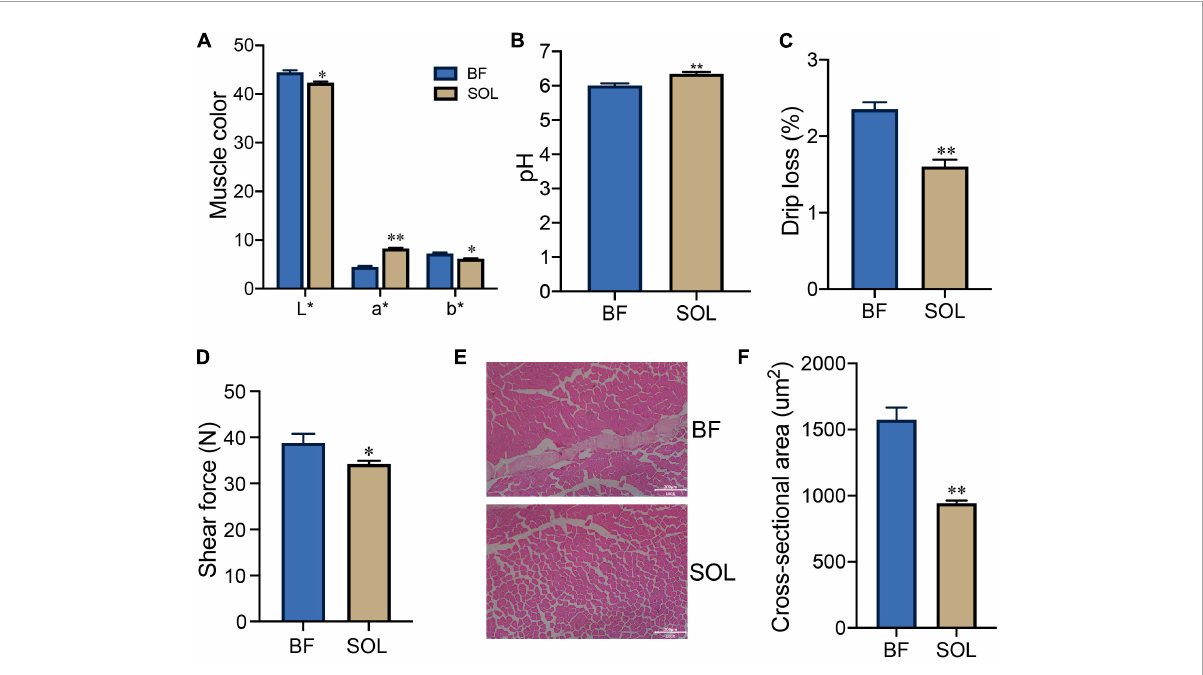
FIGURE1 Analysis of meat quality and muscle fiber characteristics of BF and SOL muscle. Determination of BF and SOL meat color (A) , pH (B) , drip loss (C) , and shear force (D) . All data were expressed as mean ± SEM ( n = 3). (E,F) HE staining and muscle fiber area analysis of BF and SOL. At least 150 muscle fibers were analyzed in each sample. Scale bars, 200 µ m. ∗ P < 0.05 and ∗∗ P <